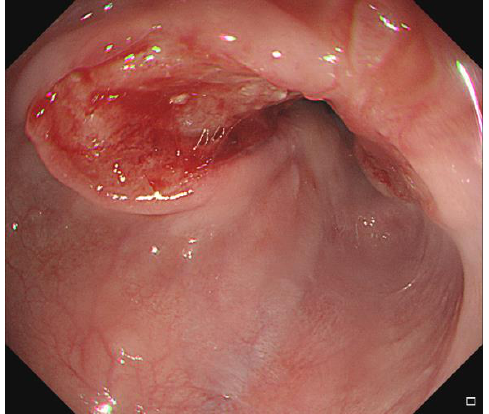
Figure 1. Endoscopic finding of the esophageal lesion.